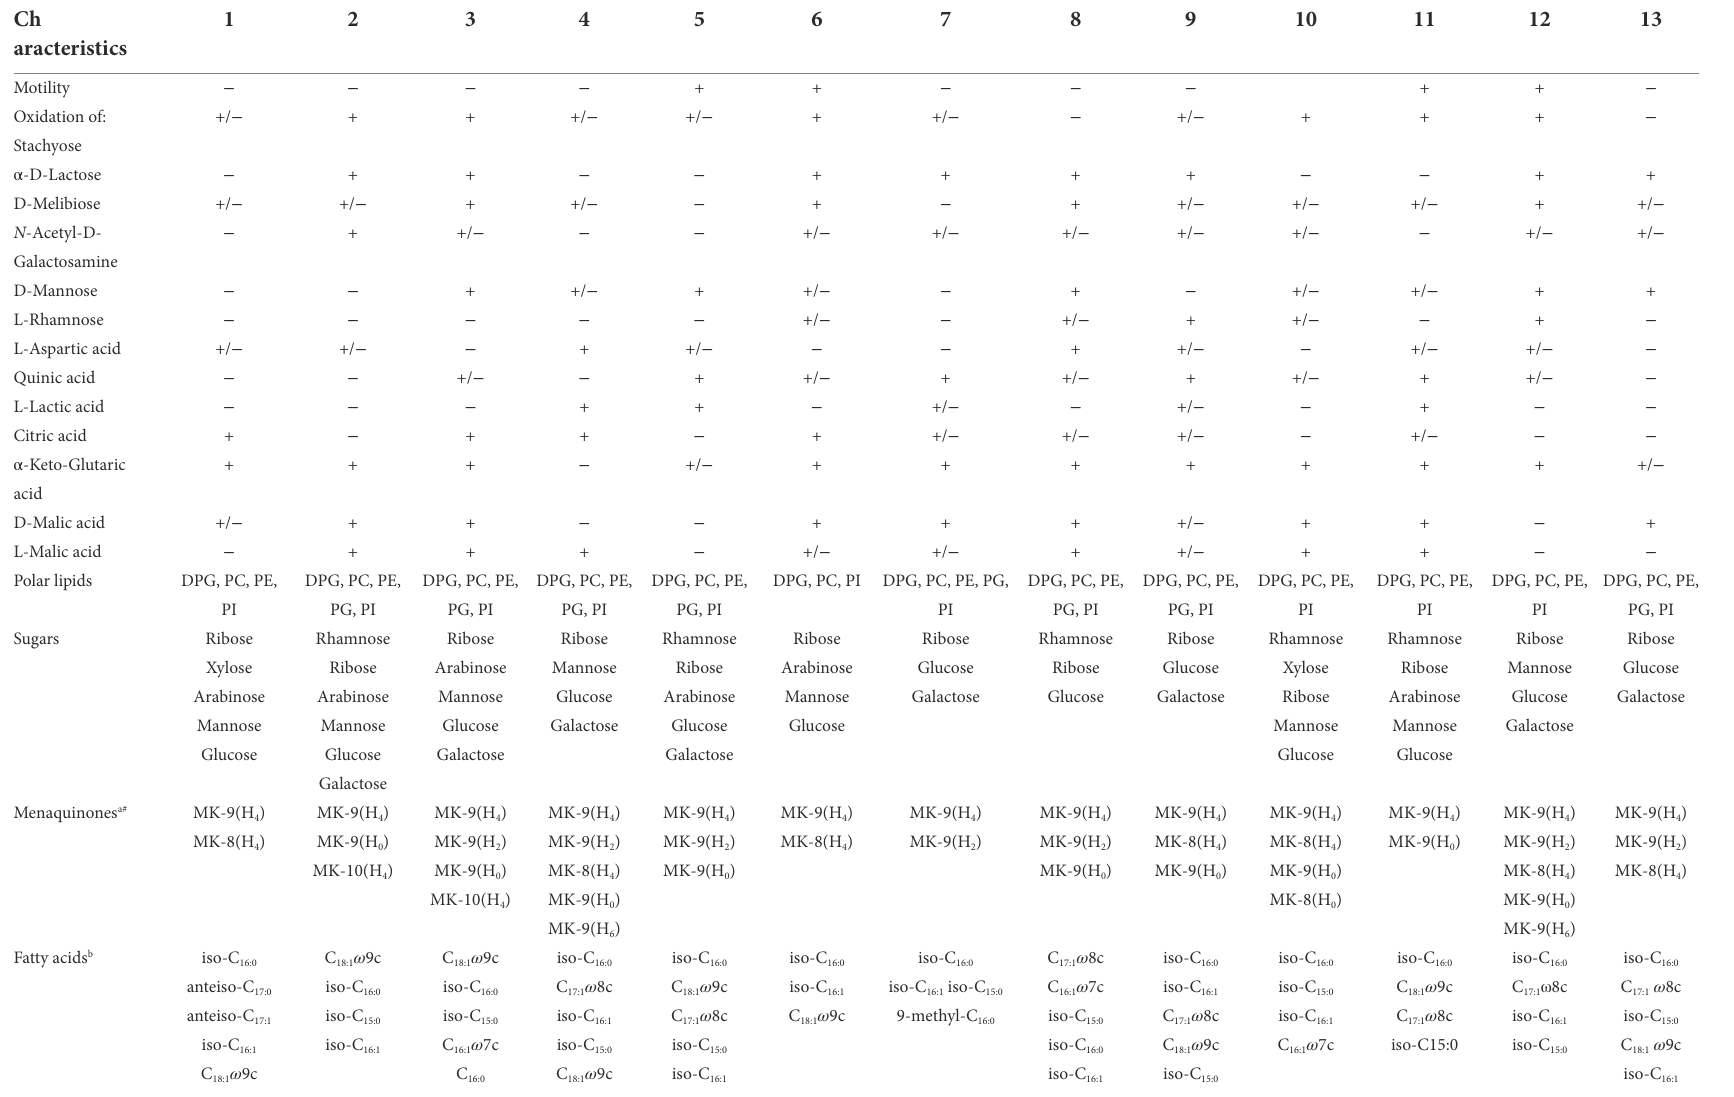
Strains: 1, strain DSM 44205 T ; 2, strain DSM 44268 T ; 3, strain DSM 44269; 4, strain DSM 44270 T ; 5, strain DSM 44272 T ; 6, B. aggregatus DSM 4725 T ; 7, B. atacamensis NRRL B-65468 T ; 8, B. capsensis DSM 46835 T ; 9, B. colisei DSM 46837 T ; 10, B. endophyticus DSM 45413 T ; 11, B. jejuensis DSM 19597 T ; 12, B. saxobsidens DSM 44509 T ; 13, B. xanthinilyticus DSM 46842 T . +, positive reaction; − , negative reaction; +/ − , ambiguous; DPG, diphosphatidylglycerol; PE, phosphatidylethanolamine; PG, phosphatidylglycerol; PI, phosphatidylinositol; PC, phosphatidylcholine; MK,